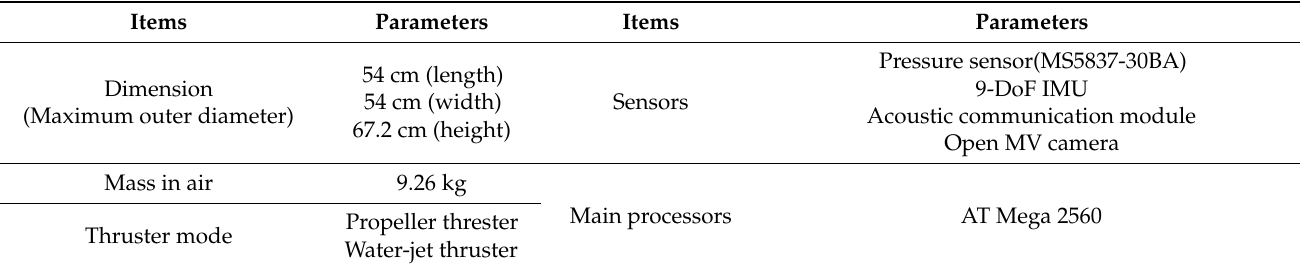
Table 1. The technical specification of the FURS.